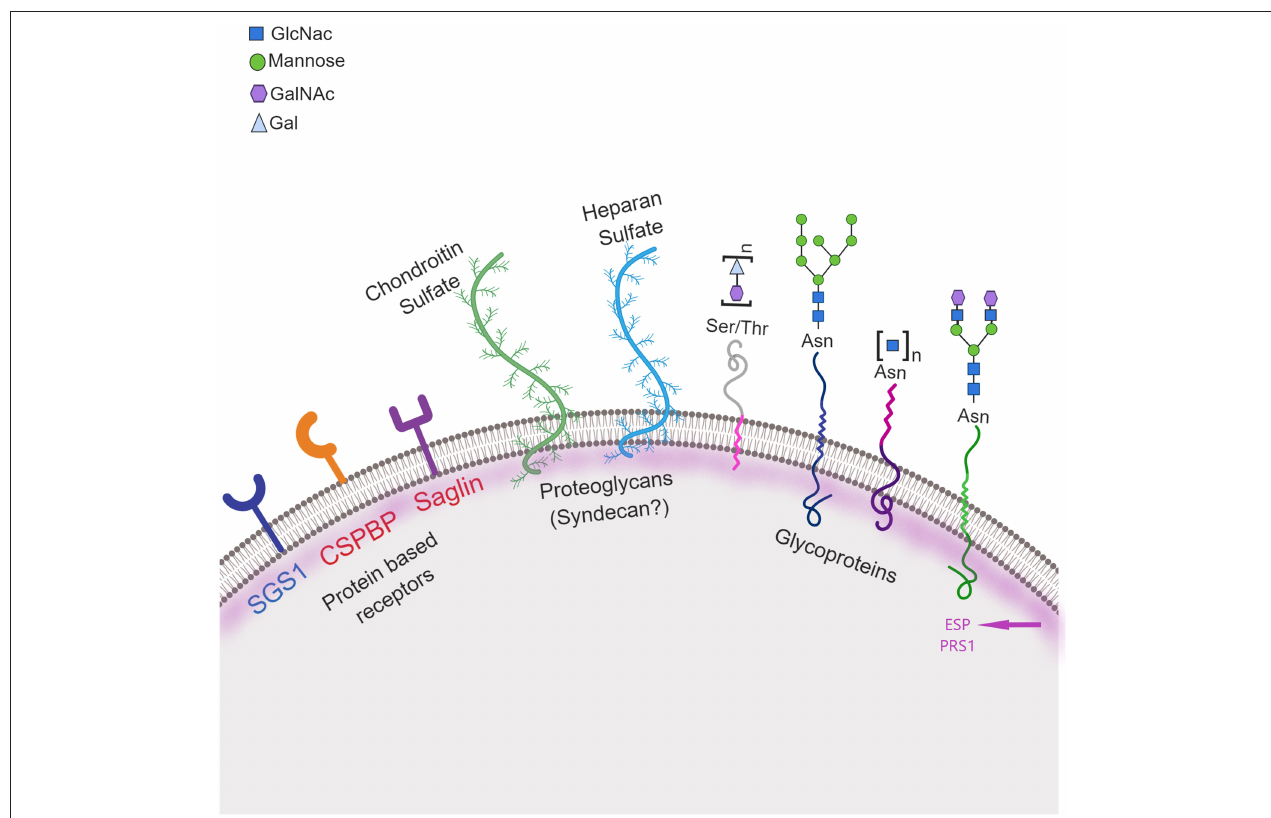
FIGURE 3 | Schematic representation of mosquito molecules involved in salivary gland penetration by sporozoites. Three classes of molecules on the mosquito salivary gland surface may be involved in recognition, attachment and invasion by the parasite: protein receptor-based, including: CSPBP—circumsporozoite binding protein and Saglin, both identified in An. gambiae (in red) and SGS1 identified in Ae. aegypti (in blue); glycoproteins including proteins containing carbohydrate moieties, specifically N -acetylglucosamine (GlcNac), mannosyl, N -acetylgalactosamine (GalNac), and galactose (Gal) moieties; and proteoglycans including both chondroitin and heparan sulfate. Two other proteins, ESP—Epithelial Serine Protease and PRS1— Plasmodium Responsive Salivary 1 are also involved in this process. Ser, Serine; Thr, Threonine; Asn, Asparagine. Created with